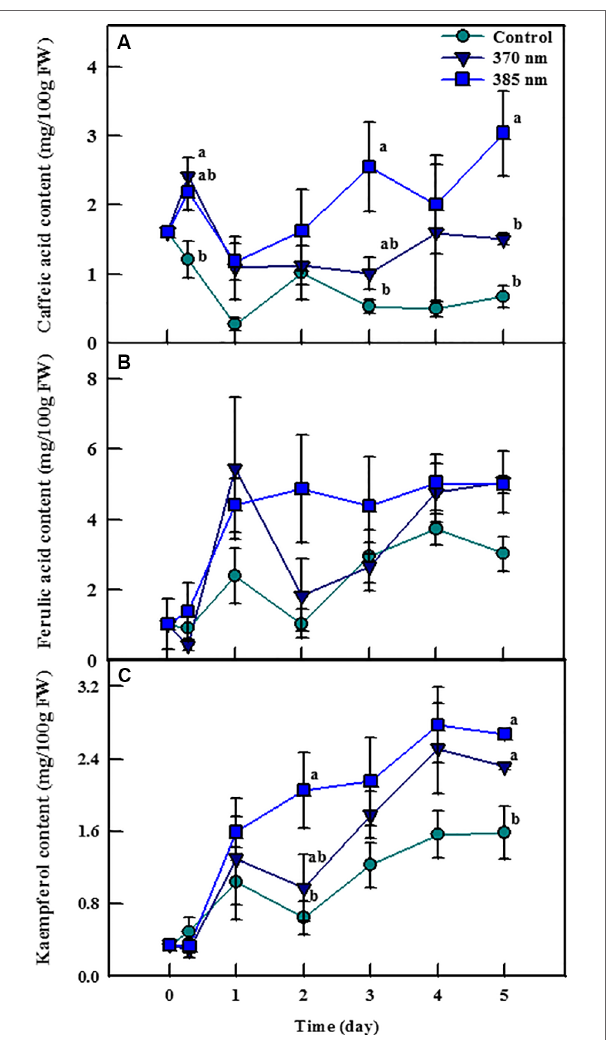
FIGURE 4 | Individual phenolic compounds [caffeic acid; (A) ferulic acid; (B) and kaempferol; (C) ] of kale subjected to two types of UV-A LED lights for 5 days. The vertical bars indicate standard errors (n = 4). Different letters indicate significant differences, as assessed by ANOVA ( p <